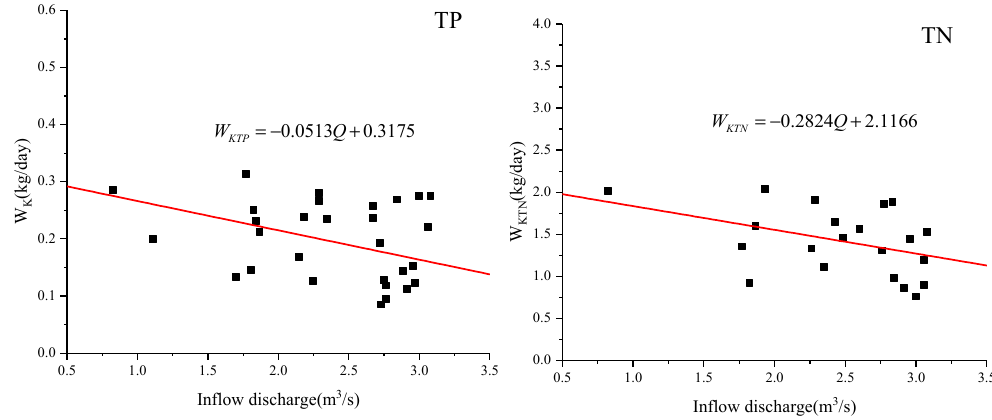
Figure 10. Relationship between amount of degradation and inflow discharge in Xuanwu Lake. We fit each scatter plot to linear function. The equation is: W = B1* Q + B2, and B1, B2 are constant parameters. The B1 for each line (left to right) is: − 0.0513, − 0.2824. The B2 for each line (left to right) is: 0.3175, 2.1166. The coefficient of determination, R-squared, for each line (left to right) is: 0.1872, 0.1795.